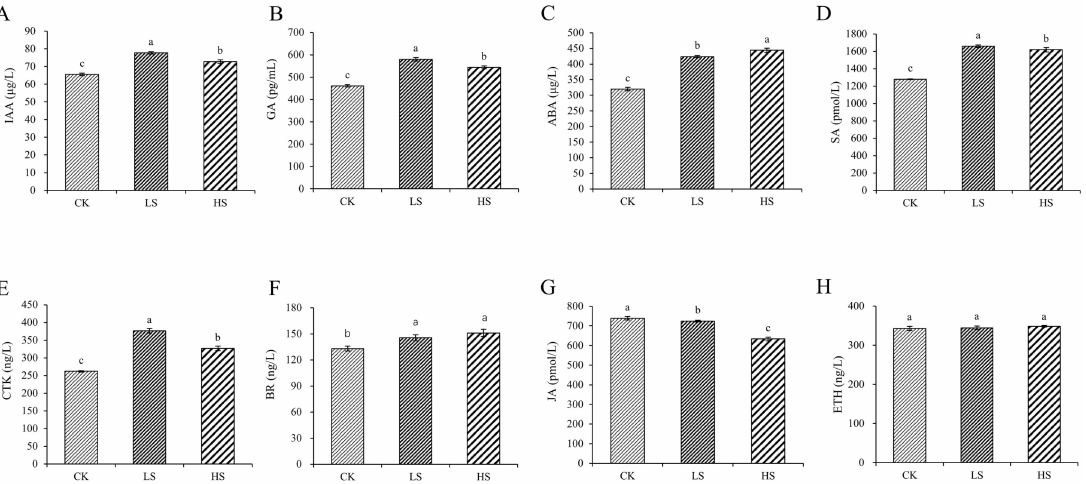
Figure 1. Changes in plant hormone content in P. koraiensis under light stress. ( A ) IAA; ( B ) GA; ( C ) ABA; ( D ) SA; ( E ) CTK; ( F ) BR; ( G ) JA; ( H ) ETH. CK: control. LS: light shade. HS: heavy shade. The error bars represent the standard error. Different letters indicate significant differences among different treatments.